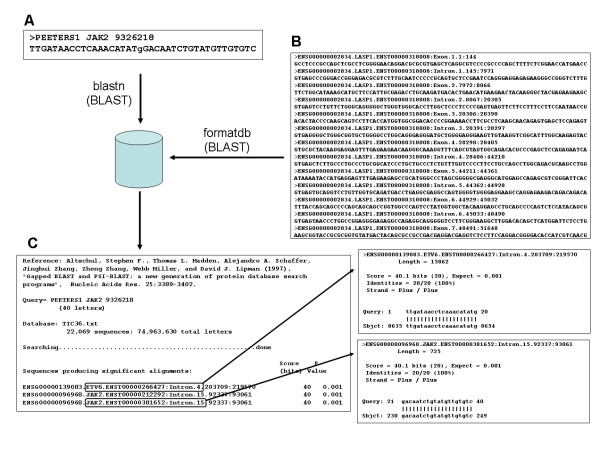
Outline of the process of mapping translocation breakpoints. Each junction sequence obtained from the literature or nucleotide database (A) was blasted against a database (B) comprising the genomic sequence of all genes known to be involved in reciprocal translocations in human tumors. Inspection of the BLAST output (C) identifies the specific region of each gene involved in the translocation. In the case of genomic fusion sequences, like the one shown in A, BLAST also identifies the nucleotide position of the breakpoint on both translocation partner genes (C, right panels). In this example the breakpoints are located in nucleotide 8654 of intron 4 of ENST00000266427 (ETV6) and in nucleotide 230 of intron 15 of ENST00000381652 (JAK2).